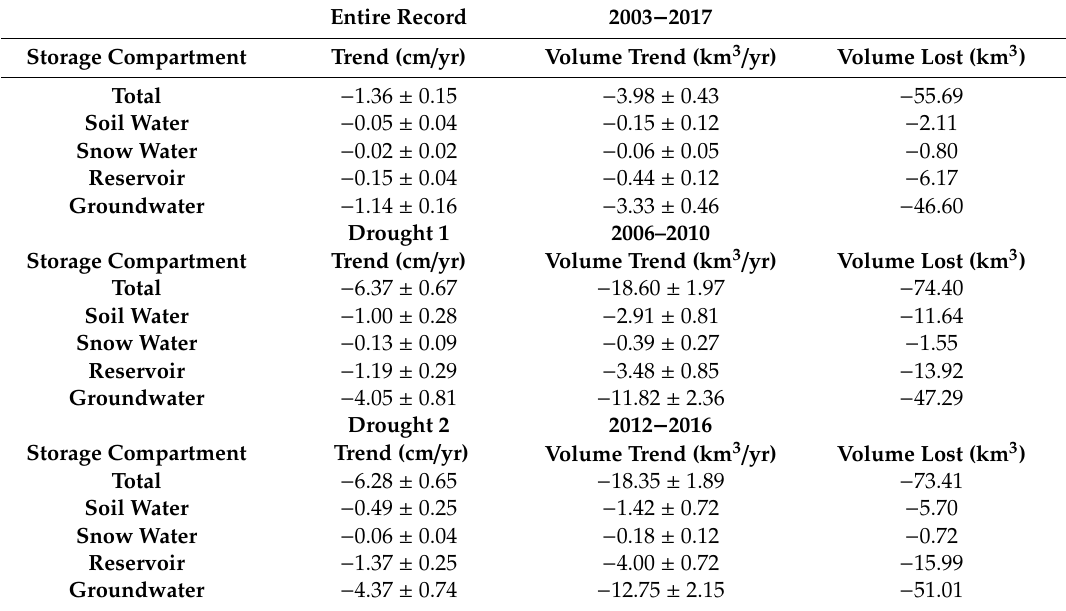
Table 1. Estimates of change in various components of the hydrologic cycle for the periods 2003 − 2017 (top), 2006 − 2010(middle), and2012 − 2016(bottom). TotalwaterstorageisfromtheGravityRecoveryand Climate Experiment (GRACE), soil water and snow water storage are from model simulations (NLDAS), and surface water storage in the form of reservoirs is from the DWR. Estimates for groundwater storage are calculated in this study, and 1-sigma standard errors are shown for each